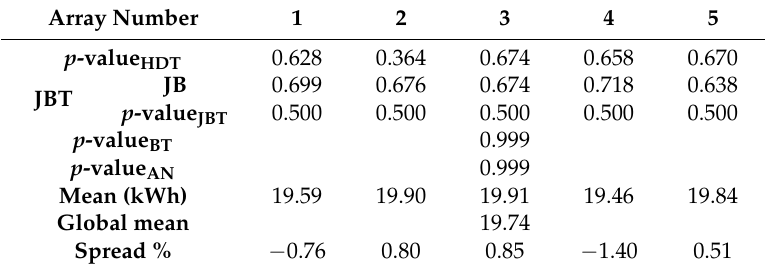
Table 1. p -Value of HDT, JBT, BT, ANOVA for the energy distribution of the arrays, and mean in kWh and spread with respect to the global mean for one-month analysis (January).